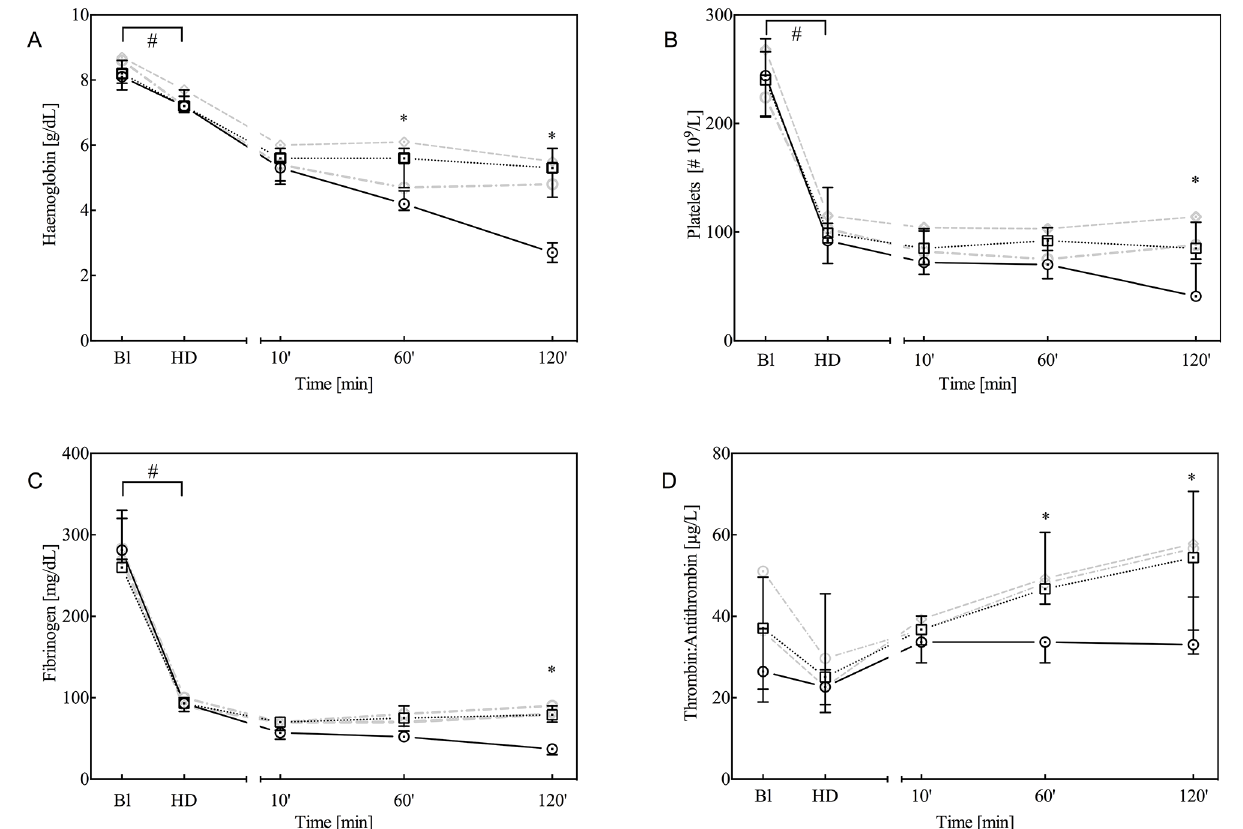
Fig 1. Haemoglobin (A), platelet count (B), fibrinogen (C) and thrombin-antithrombin (TAT; D) levels at baseline (Bl), after haemodilution (HD) and 10, 60 and 120 minutes after trauma. Data are presented as the median with inter-quartile ranges (IQR) for controls (solid black line, n = 7) and animals treated with 90 μ g/kg rFVIIa (dotted black line, n = 7). For comparison, data from animals treated with either 180 or 360 μ g/kg rFVIIa are presented as grey dotted lines. * P < 0.05 control versus rFVIIa; # P < 0.05 over time between baseline and haemodilution.